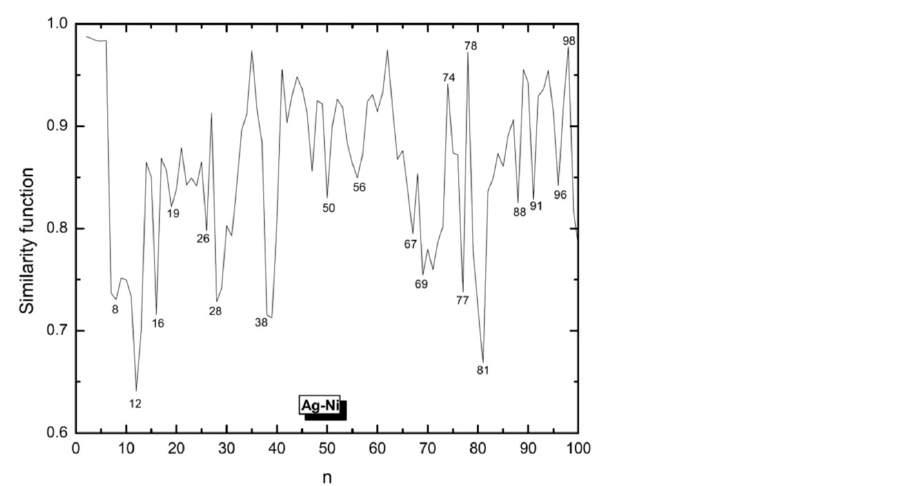
Figure 4. Similarity function for the comparison of silver clusters with nickel clusters. Structures of both systems have been defined by the same EAM potential model but global optimization of Ag clusters have been done by BH and those for Ni are the results of Aufbau/Abbau optimizations. The similarity function is based on the radial